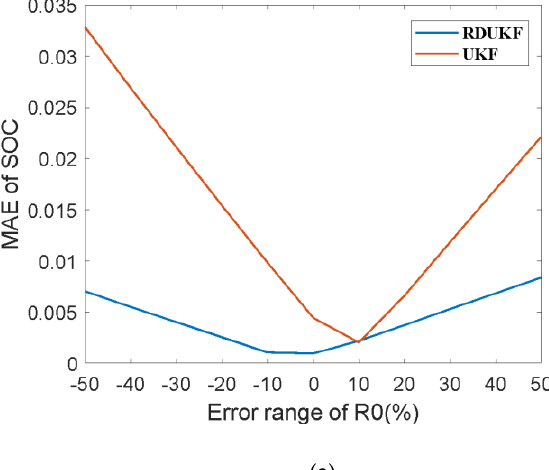
0 ; ( b ) RMSE according to deviations in R 0